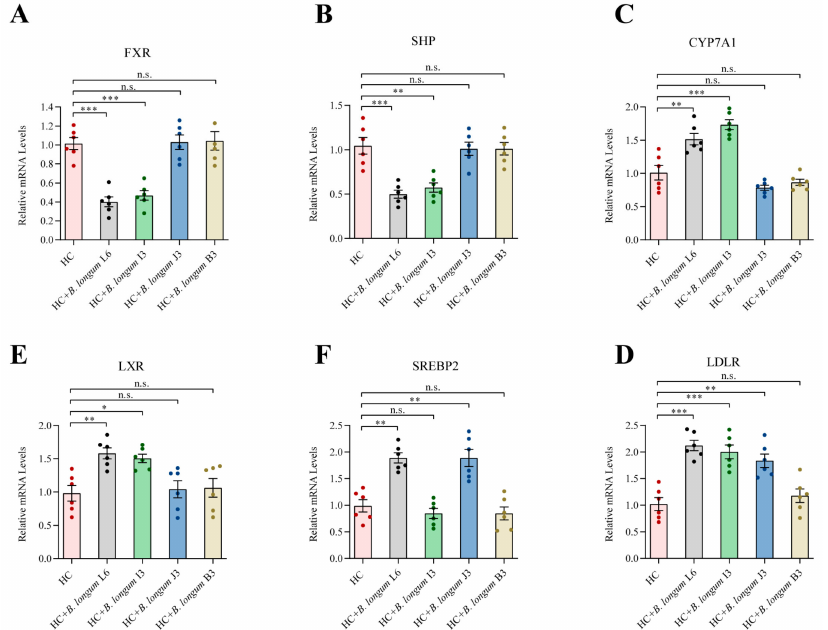
Figure 4. The effects of four B. longum strains on liver expression of genes involved in cholesterol and bile acid metabolism by RT-PCR. ( A ) FXR; ( B ) SHP; ( C ) CYP7A1; ( D ) LXR; ( E ) SREBP2; ( F ) LDLR. Each column represents the means ± standard error of the mean ( n = 6). *** represents p < 0.001, ** represents p < 0.01, * represents p < 0.05, n.s represent non-significant with p > 0.05.